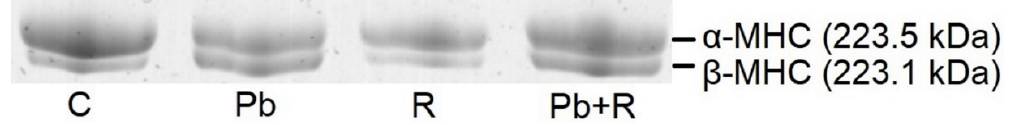
Figure 9. The work–afterload relationships of trabecules ( A ) and papillary muscles ( B ) in the experimental groups. The number of preparations is given in brackets. Data are presented as mean ± S.D.